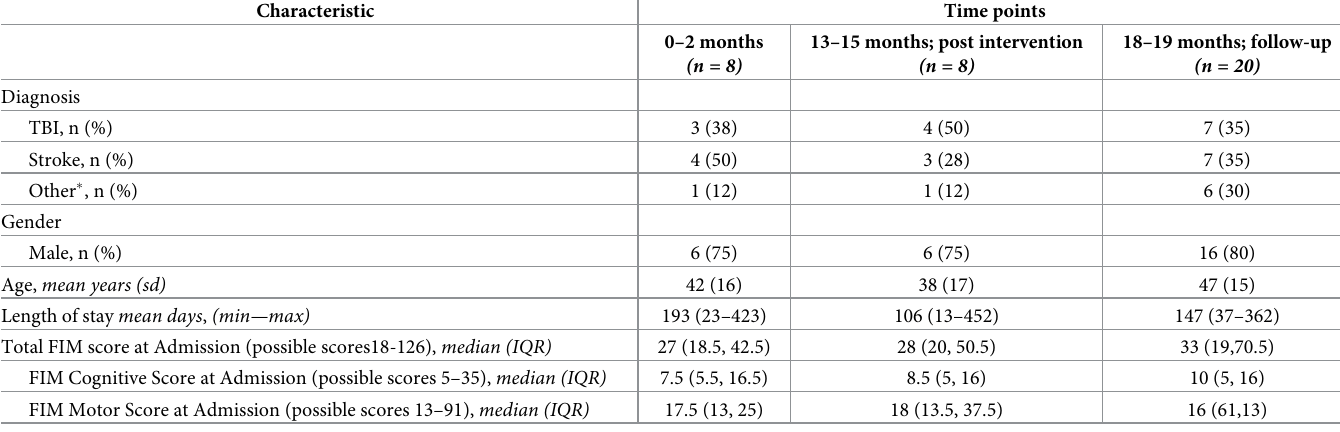
Table 3. Patient demographic characteristics of randomly selected patients included at each audit time point.